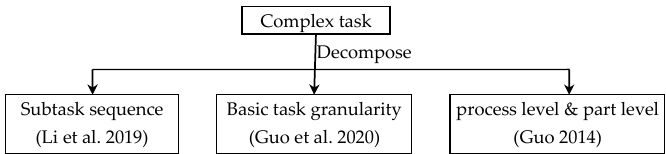
Figure 1. The relative task-decomposition methods.